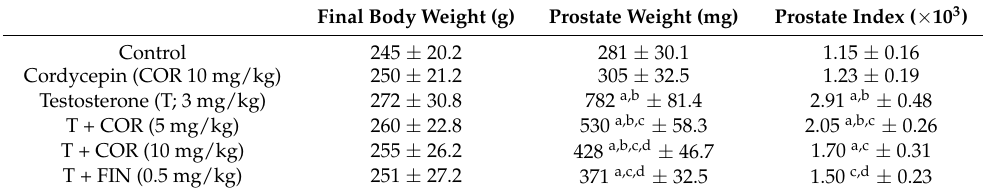
Table 1. Effect of cordycepin on prostate weight and index in testosterone-treated rats.